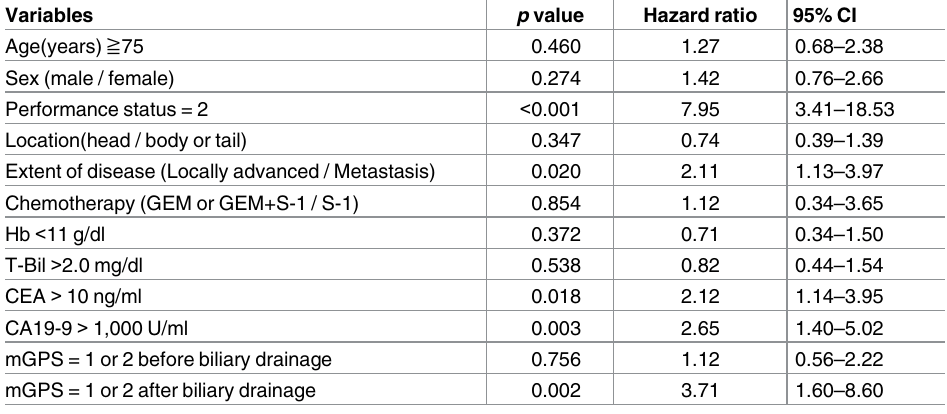
Table 2. Univariate analysis in relation to overall